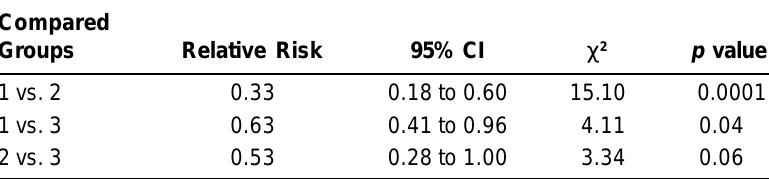
Intergroup Comparison of the Parasitoscopic Results